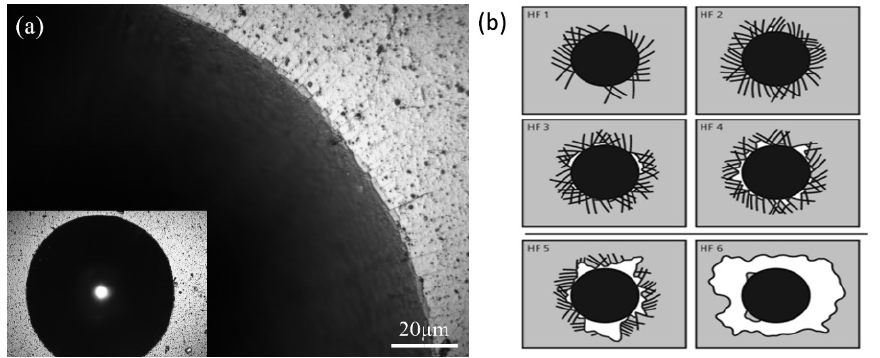
Figure 9. ( a ) Indentation profile of the coating; ( b ) VDI ‐ 3198 standard.